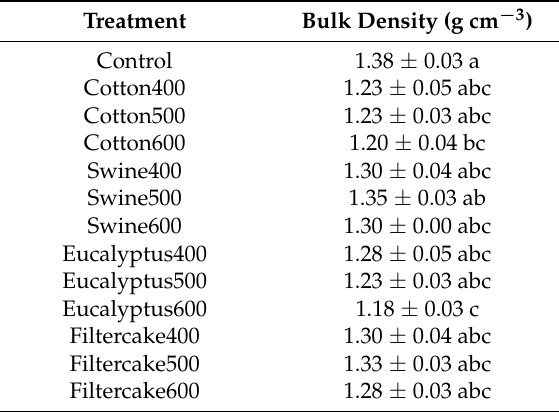
Figure 5. Mean available water content (%) determined from intact soil cores ( n = 4). Capital letters represent significant differences between the feedstocks while lowercase letters represent significant differences between the temperatures (Tukey test; p < 0.05). Table 3. Bulk density from intact soil cores. Lowercase letters indicate significant differences between Final bulk density determined from intact soil cores showed no differences between the the treatments ( n = 4, Tukey test, p < temperatures for each feedstock, and little difference between the feedstocks. Although most of the biochar treatments had lower mean bulk density than the control, only the bulk densities of soil with cotton biochar at 600 °C and eucalyptus biochar at 600 °C were significantly lower (Table 3).